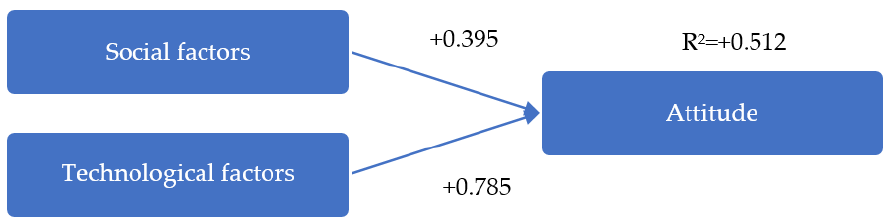
Figure 9. Regression model with coefficients for variables in Model 2.